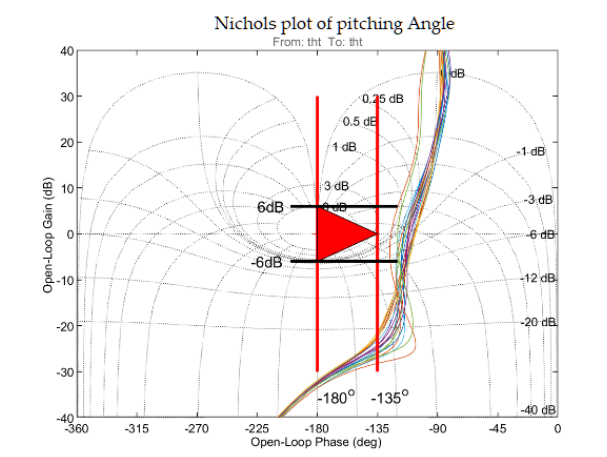
Figure 16. The Nichols diagram of pitch rate loop breaking at elevator.